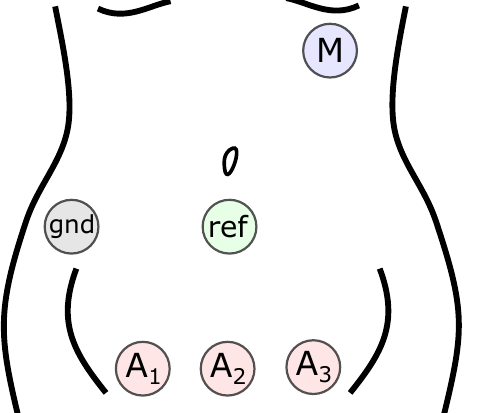
Figure 2. The NI-FECG electrode configuration used in this